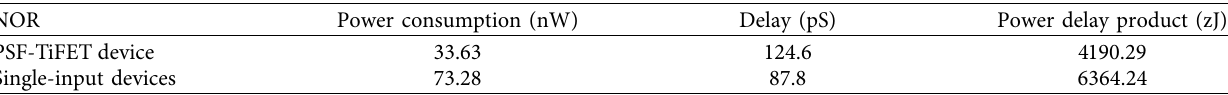
Table 4, the power consumption and power delay product of